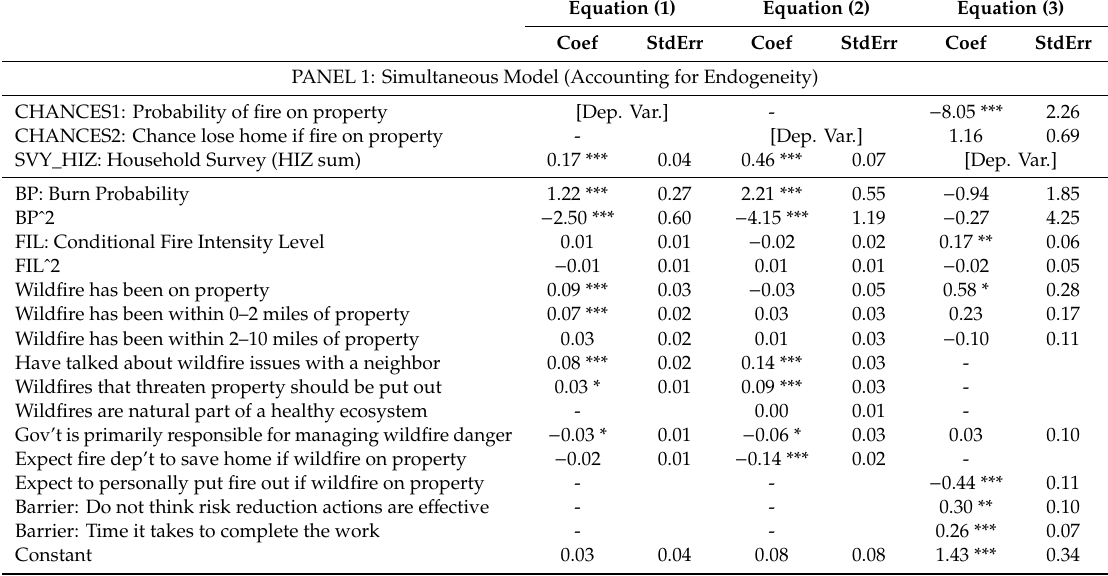
Table 5. Estimated coe ffi cients of separate and simultaneous regression models of survey respondents’ self-reported perception of likelihood of wildfire on their property (CHANCES1), likelihood of damage to their home if that occurs (CHANCES2), and the survey-generated estimation of mitigation (SVY_HIZ). For all outcome variables, higher values correspond to higher risk (n = 1643). Equation (1) Equation (2) Equation (3) Coef StdErr Coef StdErr Coef StdErr PANEL 1: Simultaneous Model (Accounting for